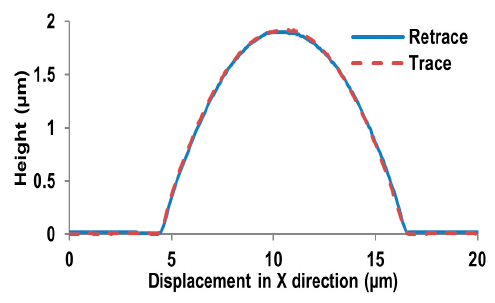
Figure 15. The profile of a section scanned by AFM.